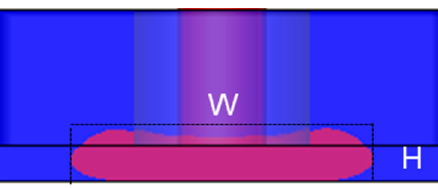
Figure 8. A liquid fraction of a simulated extruded strand in xy-plane and demonstration of how W and H of the cross section is made.